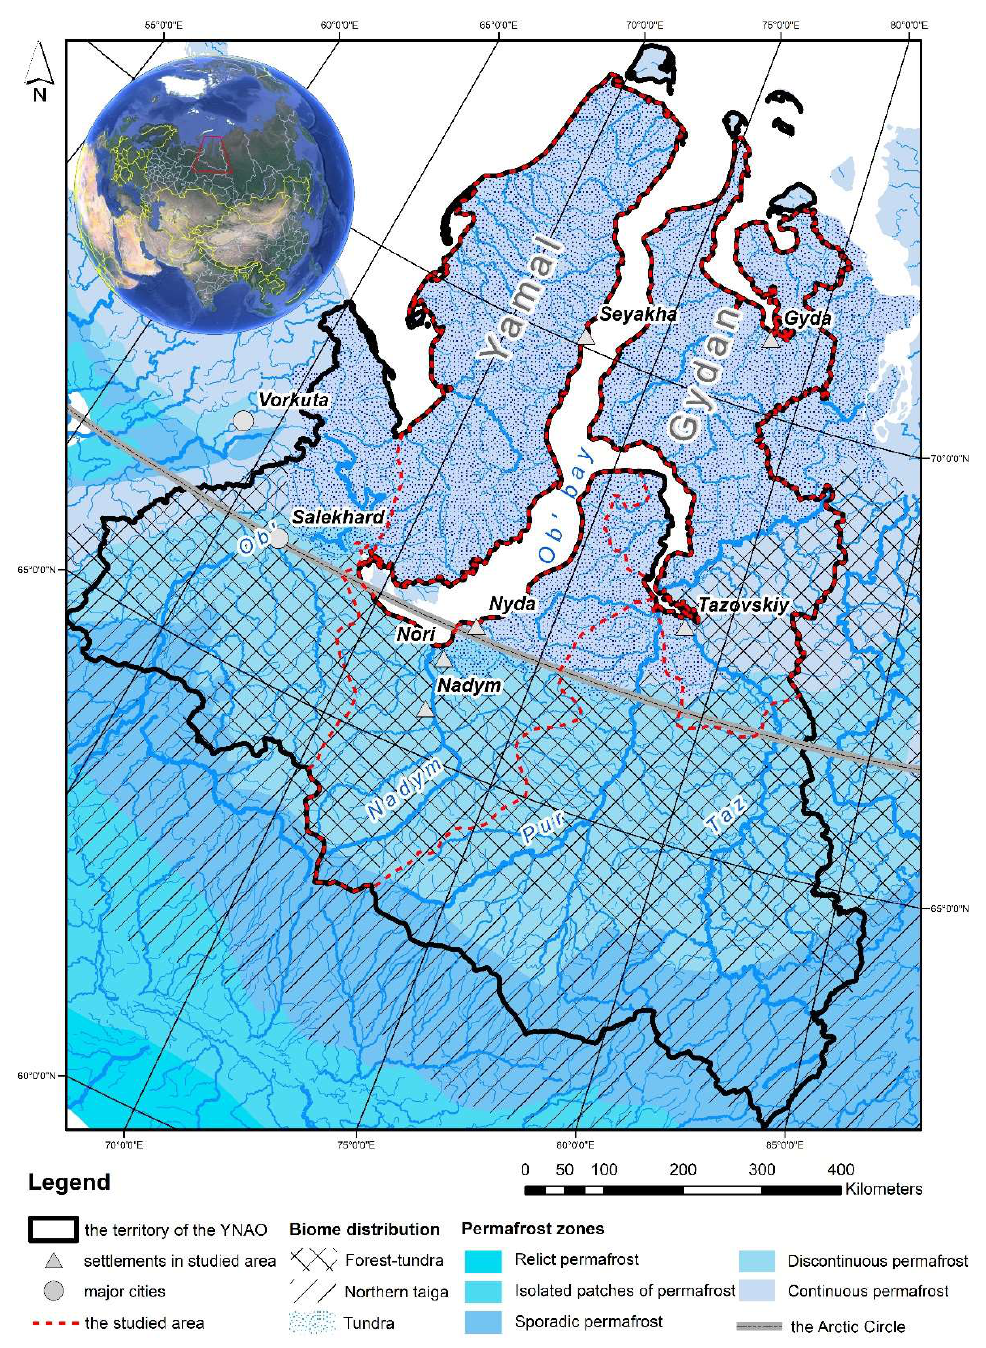
Figure 1. Map of the Yamal Nenets Autonomous Okrug (source: from multiple sources). The climate is arctic and subarctic [56]. The winter is long (more than 8 months) and severe, and the duration of stable frosts varies from 220 days in the north to 180 days in the south (at the Arctic Circle). Strong winds and snowstorms are characteristic. The av- erage temperature in January varies from −22 °C in the southern part to −27 °C in the north. The average temperature in July varies from +4 to +16 °C, and the precipitation varies from 200 mm/yr in the north to 500 mm/yr in the south, mainly in the second half of summer. In the northern part, the height of the snow cover is 20–25 cm, and its duration